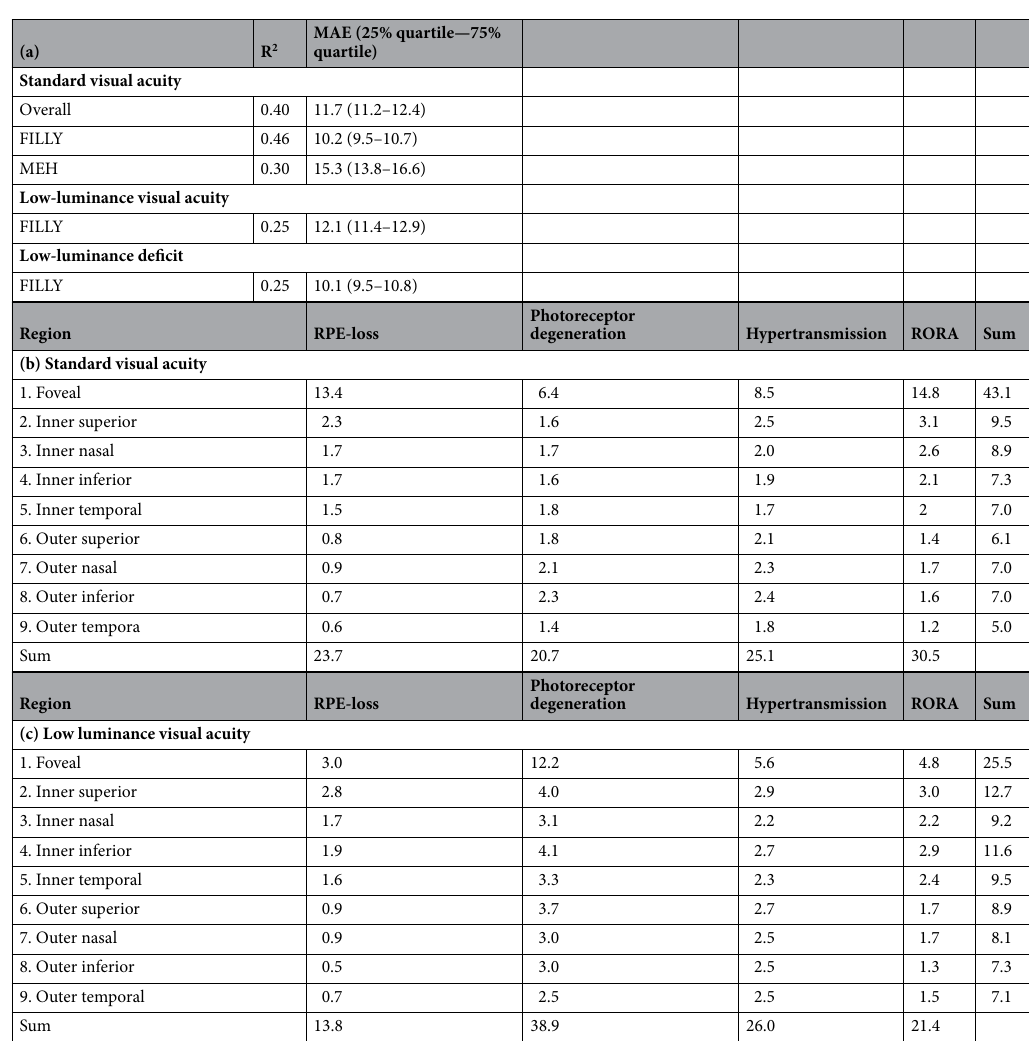
Table 3. Structure–function correlation between qOCT biomarkers of GA area and VA. (a) A random forest regression model was trained using the deep-learning segmentation output (i.e. the raw probabilities at the voxel level for each feature (RPE-loss, photoreceptor degeneration, hypertransmission, and RORA) as input variables to predict cross-sectional VA under standard luminance conditions, low-luminance VA, and low-luminance deficit in ETDRS letters. For VA under standard-luminance conditions, separate models were evaluated for: (i) BCVA under RCT conditions i.e., FILLY; (ii) VA from real-world routine care, i.e., MEH; and (iii) a third that combines the two. Model bootstrapped 100-fold with resultant regression coefficients (r 2 ) and mean absolute error (MAE) shown. Importance of qOCT biomarker features in predicting (b) standard visual acuity and (c) low luminance visual acuity was queried using machine learning. Random forests modelling was used to evaluate value of the qOCT biomarkers RPE-loss, photoreceptor degeneration, hypertransmission, and RORA in predicting cross-sectional visual acuity under standard lighting conditions (Overall model). The resultant adjusted feature importance values were summed according to location within ETDRS region and multiplied by 100 to give the percentage contribution towards the model’s performance. For example, RORA within the foveal region accounted for 16.8% of the model’s performance of r 2 0.40 MAE 11.7 ETDRS letters for standard visual